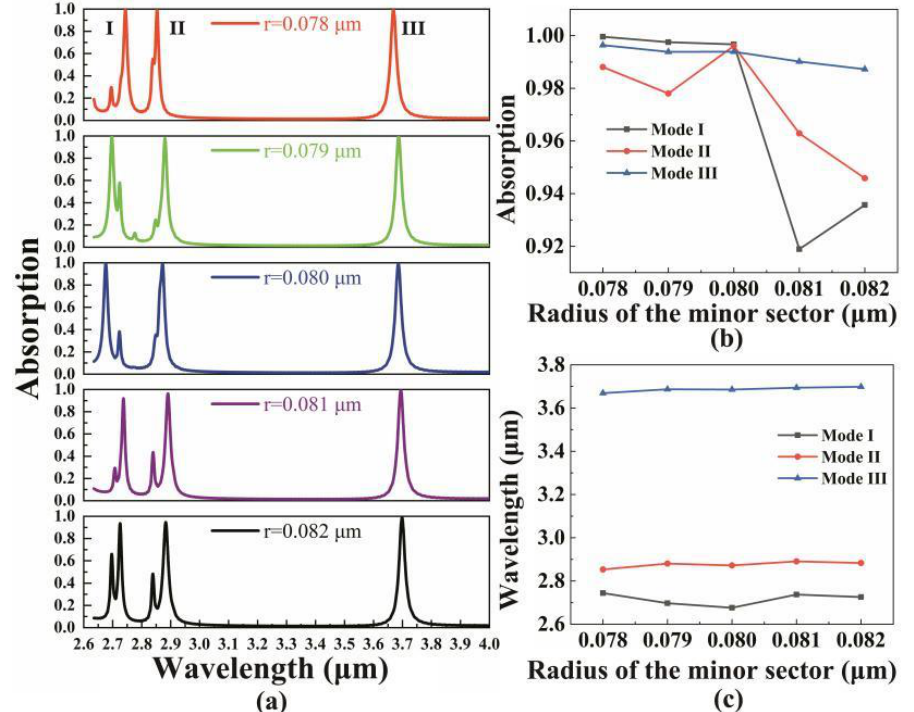
Figure 5. ( a ) An absorption wavelength changing diagram of the radius r of small sectors with the radius of the major sector fixed at R = 0.11 μm. ( b ) An absorption line chart of three resonant modes as r increases. ( c ) A wavelength line chart of three resonant modes as r increases.